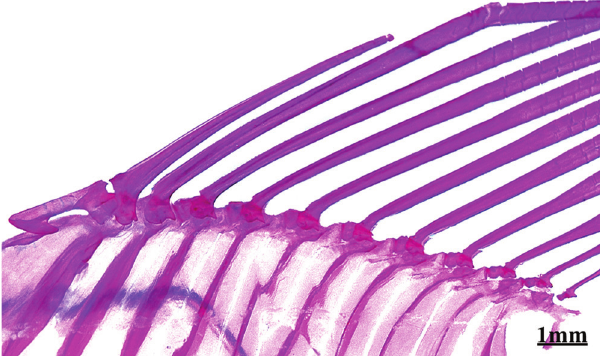
Fig. 3. Poptella actenolepis , MZUSP 122982, paratype, 61.5 mm SL, lateral view of left side of modified dorsal fin